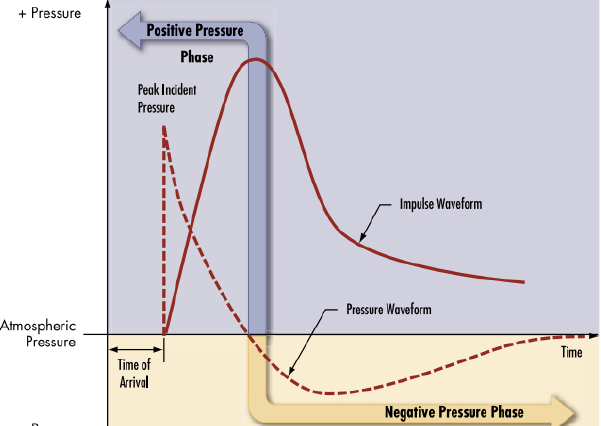
Fig.3: Representation, relationship between pressure pulse and impulse and the shock front expands pressure to surroundings pressure (negative and positive pressure phase [2].